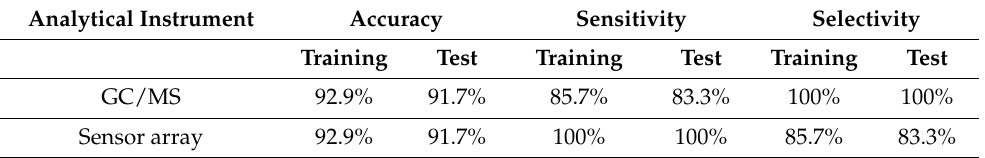
Figure 9. Box-plots of canonical variable ( A , C ) and ROC ( B , D ) calculated with GC/MS and sensor array data respect to cancer and control groups. Canonical variables were calculated with training data and applied to test data. Table 4. Distribution of LOX-1 in tumor and healthy counterpart of different grade and stage.